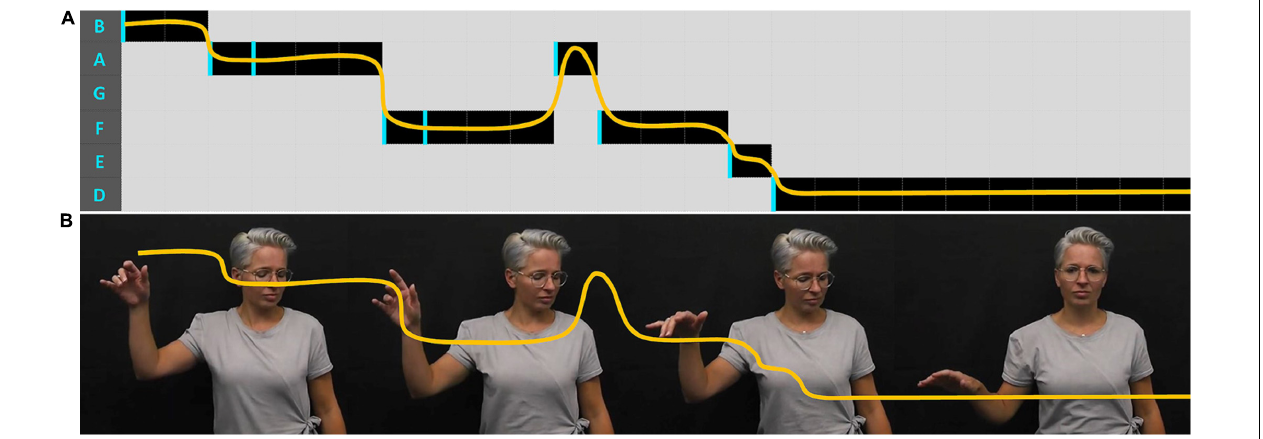
FIGURE 6 | Spatial representation of the melodic line— (A) shows a spatial visualization of the melodic line—height placement represents the note (as on a musical score), width represents time, progressing from left to right, onset of a new piano key-press indicated by a vertical line. (B) Shows the melodic line represented by movements of the right hand, over time (Stolk: This is Me—Greatest Showman,